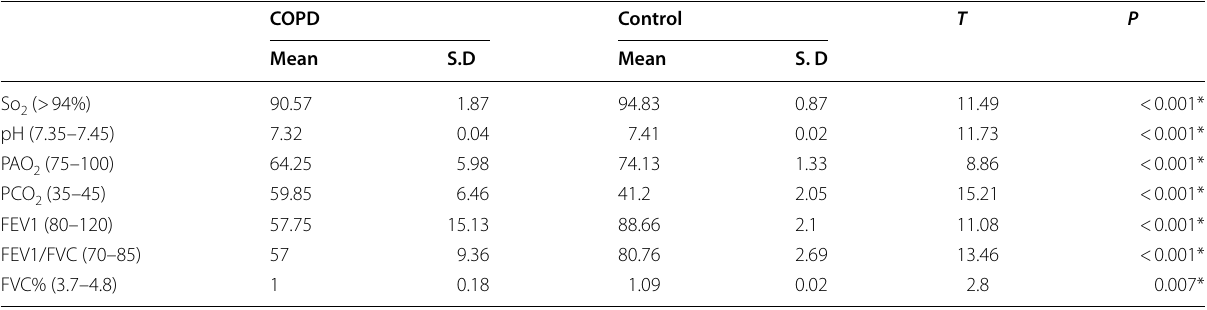
So 2 arterial oxygen saturation, PAO 2 partial pressure of oxygen, PCO 2 partial pressure of carbon dioxide, FEV1 forced expiratory volume in one second, FVC forced vital capacity *Significant